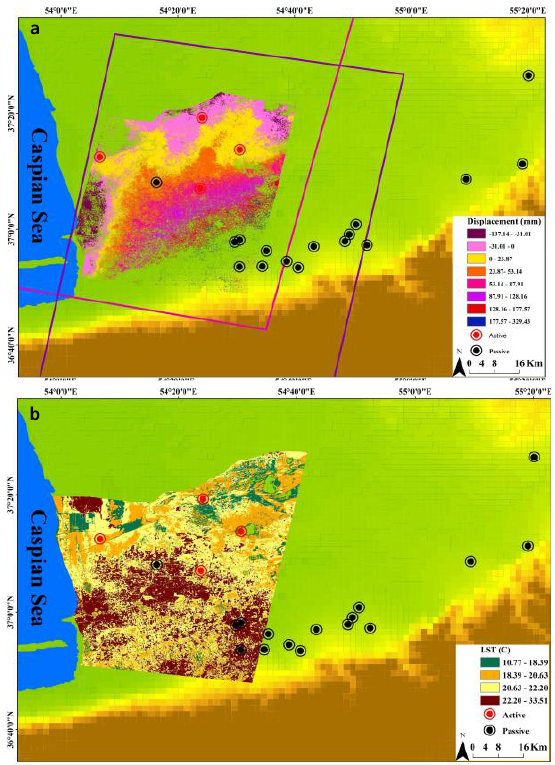
algorithm (SBAS), reduce the limitations of traditional radar